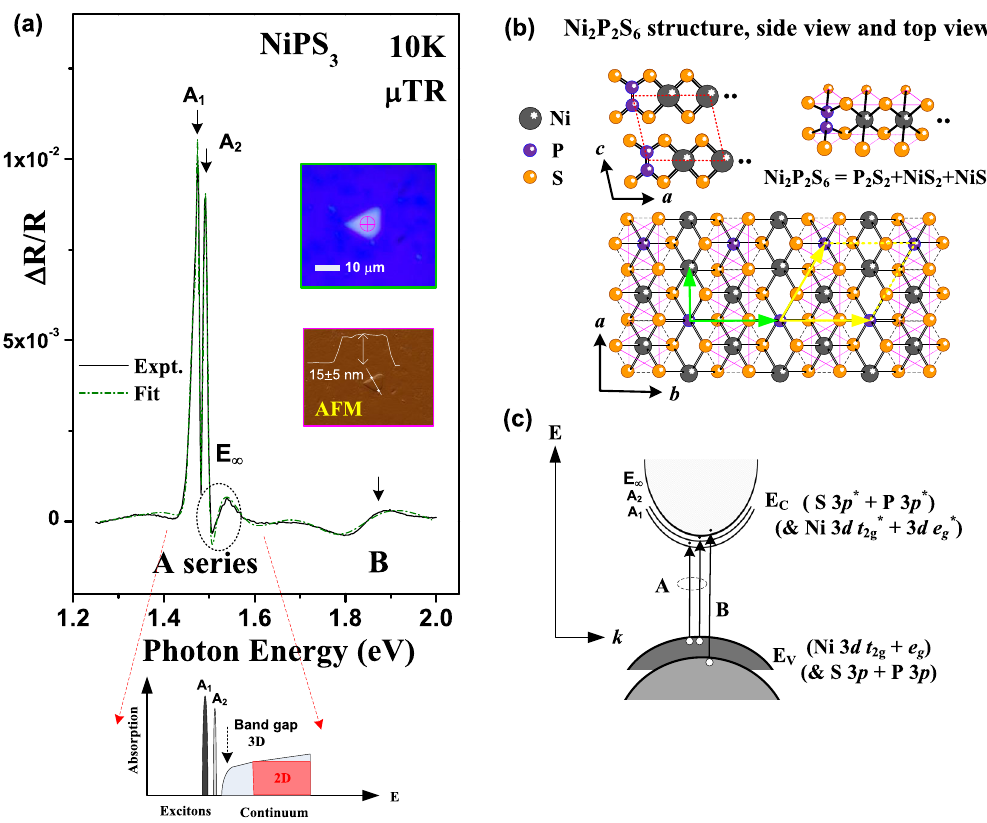
Fig. 1 Low-temperature excitonic series observed in NiPS 3 . a Band-edge excitons of the A series and B transition in few-layer NiPS 3 observed via μ TR measurements at 10 K. Insets show the microscopic image and AFM results of the few-layer sample on an SiO 2 /Si substrate. The lower inset depicts the representative scheme of Rydberg series absorption for contrast. b Atomic arrangements of the side and top views for the layered Ni 2 P 2 S 6 structure. c Representative band-edge scheme for the A series exciton and B transition in NiPS 3